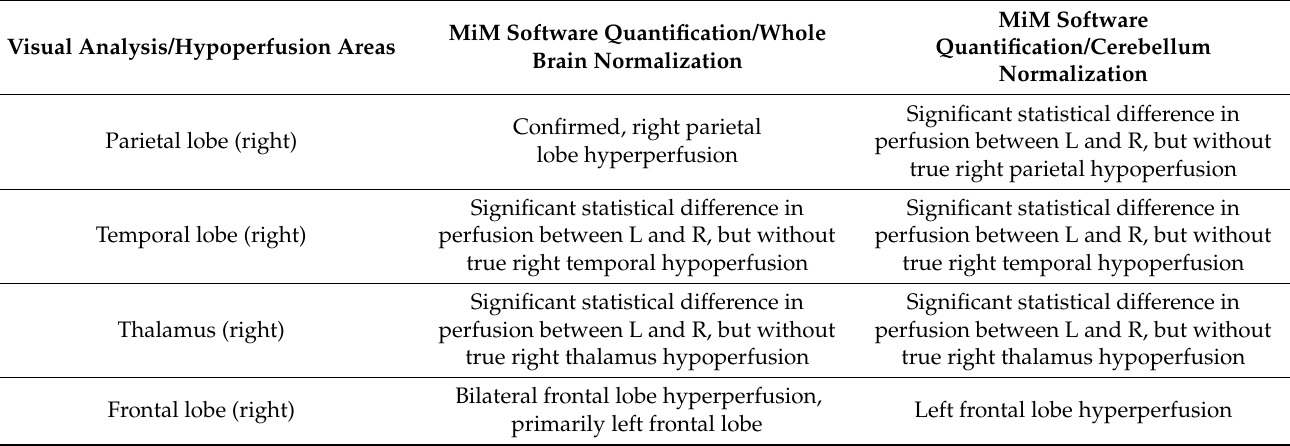
Table 2. Comparison of visualy detected perfusion anomalies with quantitatively detected perfu- sion changes.